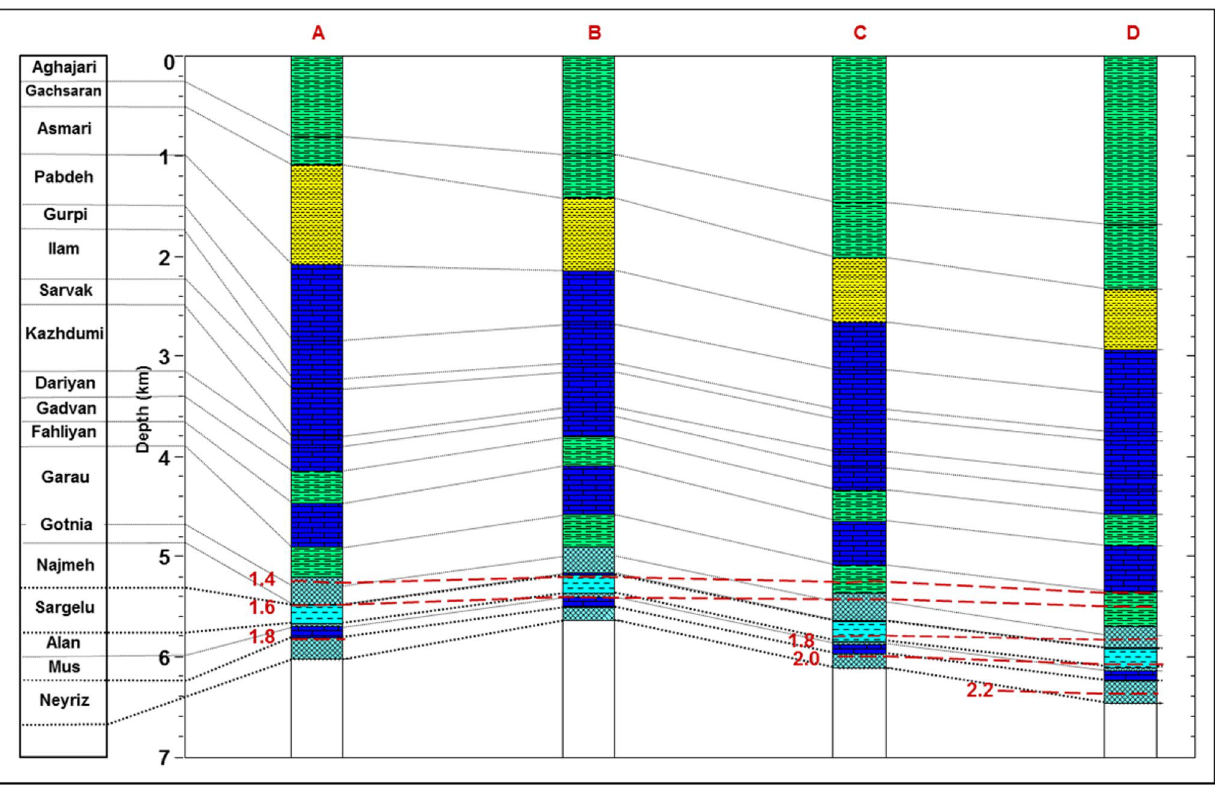
Fig. 13 Cross section showing maturity iso-values (%Ro) of organic matter through Wells A, B, C, and D across the kitchen area of the Jurassic reserve (for the location of cross section, refer to Fig. 12) Fig. 14 Cross plot of C29 sterane isomerization (Peters et al. 2005), which shows the maturity of